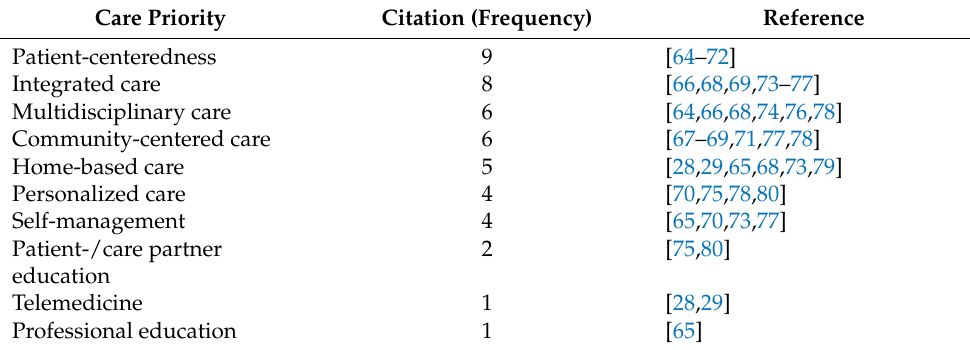
Table 3. Care Priorities for Parkinson’s Disease in Conceptual